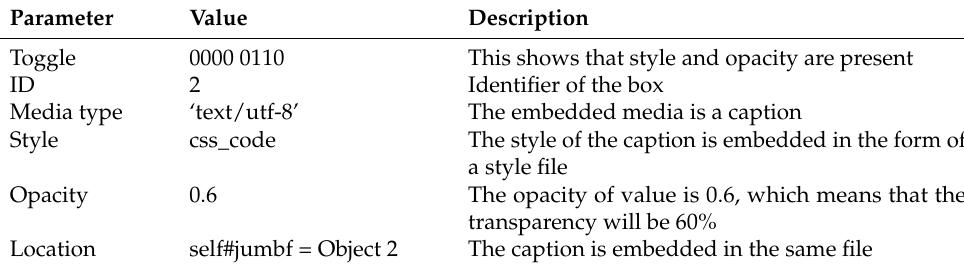
Table A11. Values of the second OBMB parameters for the third